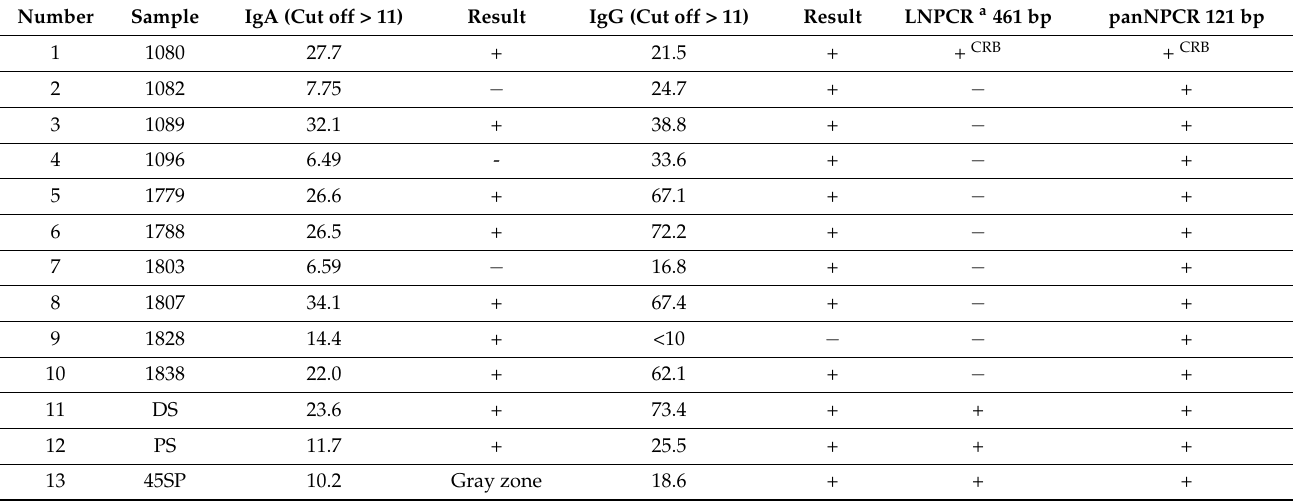
Table 4. ELISA in plasma vs. panNPCR in